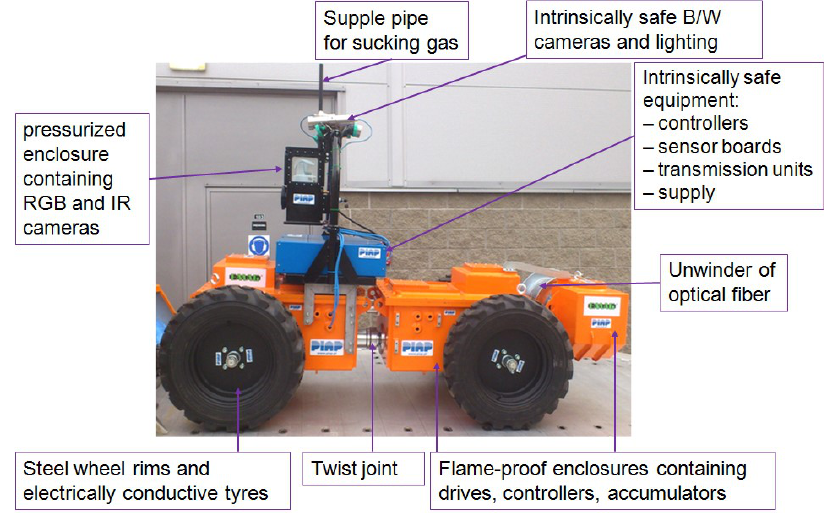
Figure 3. MPI robot by Emag-Piap consortium (Poland).